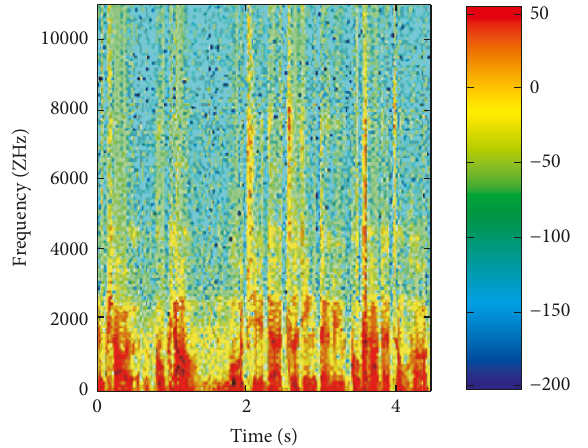
Figure 4: Time domain sequence waveform of outlier data- containing information flows obtained by the proposed method.